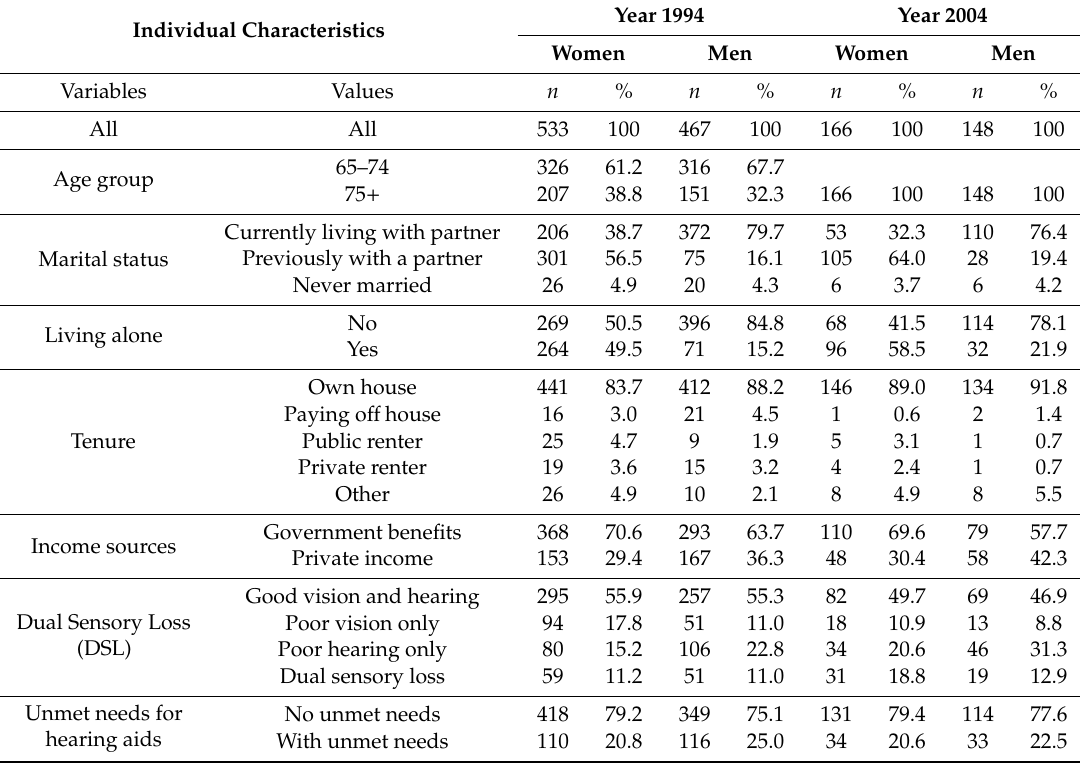
Table 2. Individual characteristics, prevalence of dual sensory loss (DSL) and unmet needs by gender in 1994 and